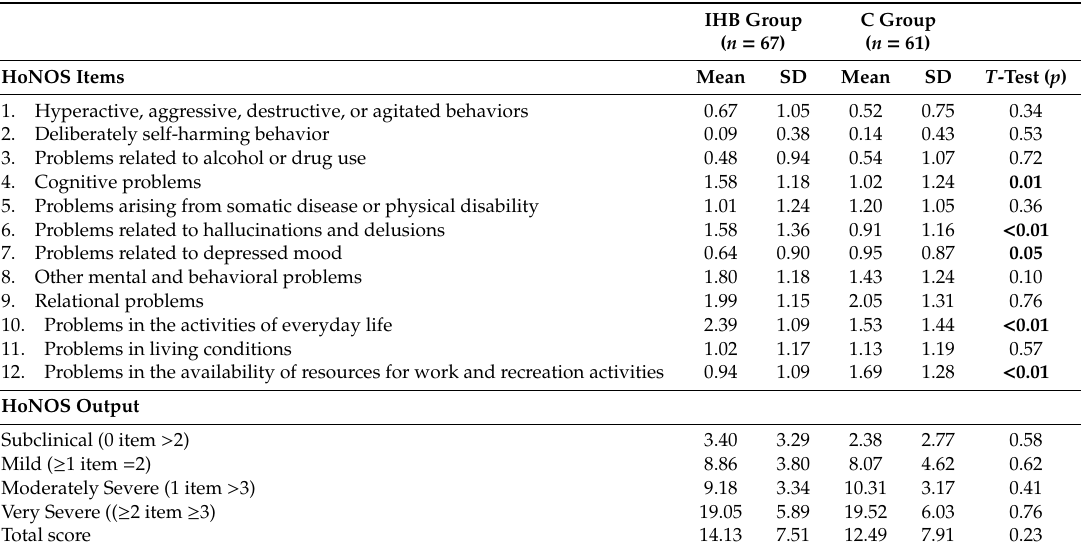
Table 2. Mean and standard deviations (SD) of scores according to Health of Nation Outcome Scale (HoNOS) items in the Individual Health Budget (IHB) and comparator groups. Significant p -values at the T -test are highlighted in bold.